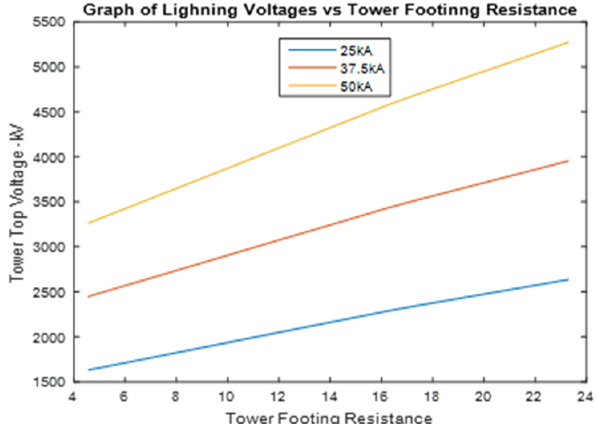
Figure 16. Enhance earthing (less than 30 ohms) vs. overvoltages.